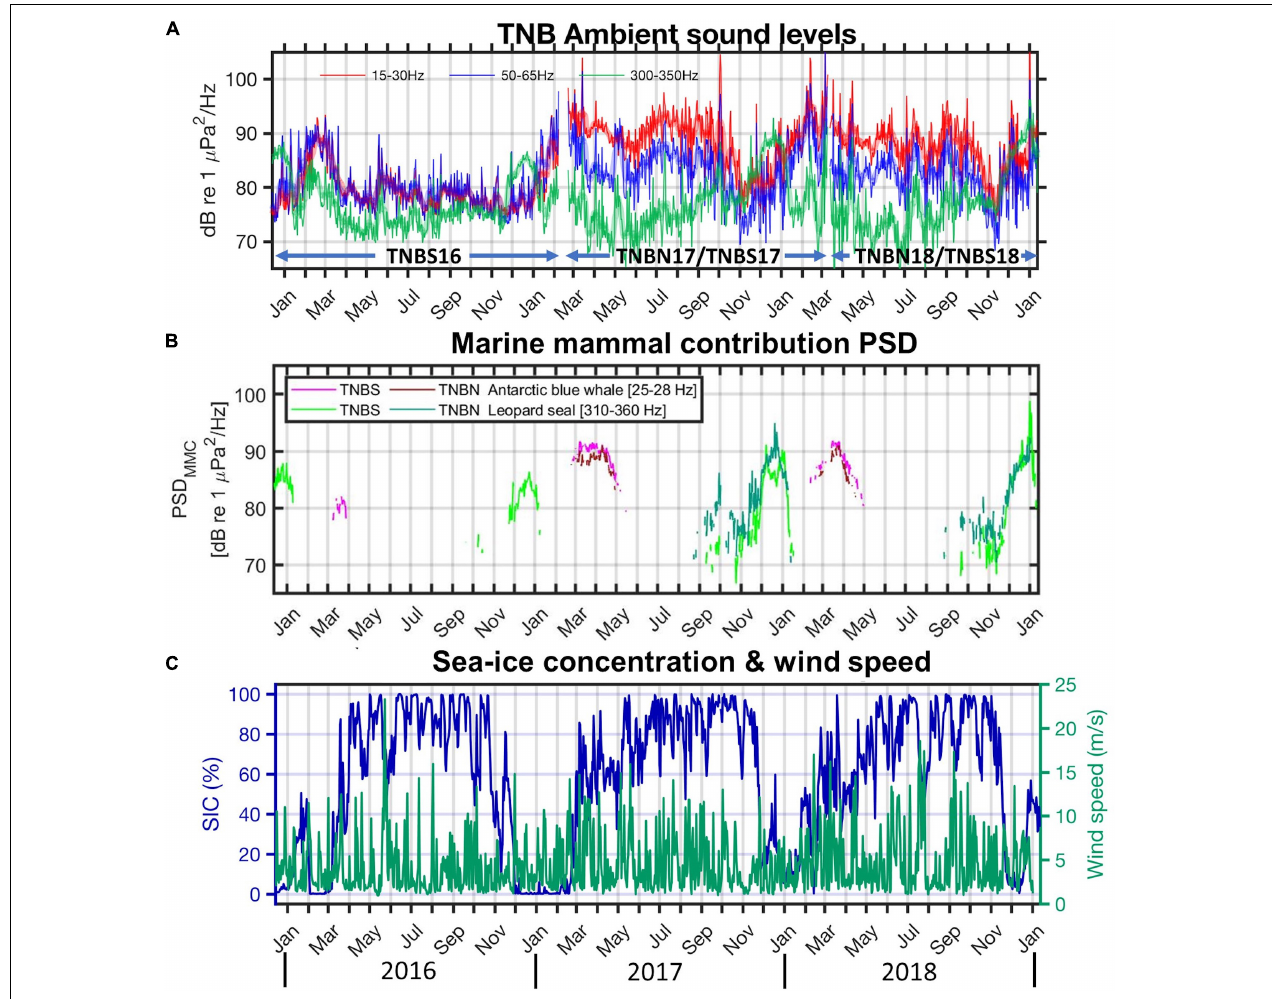
FIGURE 5 | (A) Same as Figure 4A but for TNB records. The mean sound levels are estimated by combining the north and south records in 2017 and 2018. (B) Marine mammal contributions (MMC) in the power spectral density (PSD MMC ): Antarctic blue whale contributions in TNBS and TNBN (represented by magenta and dark red lines, respectively) and leopard seal contributions in TNBS and TNBN (represented by green and dark green lines, respectively). (C) Daily averaged sea-ice concentration within a rectangular area with coordinates 75.5–74.7 ◦ S latitude and 164–166.5 ◦ E (shaded area in Figure 1D ) represented as navy lines, and time series of daily wind speed from Jang Bogo station plotted as green